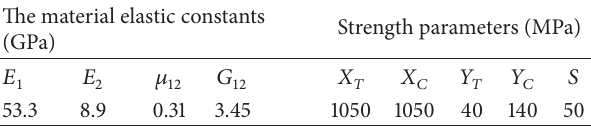
Table 1: Properties of the skin’s composite lamina. The material elastic constants